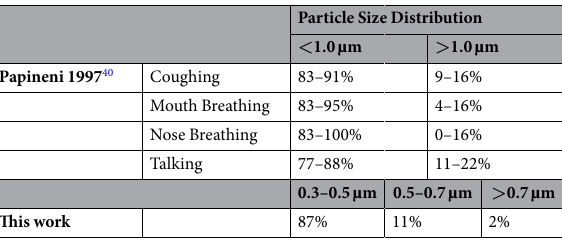
Table 1. Example particle size distributions from humans during various activities are given along with the measured values for this